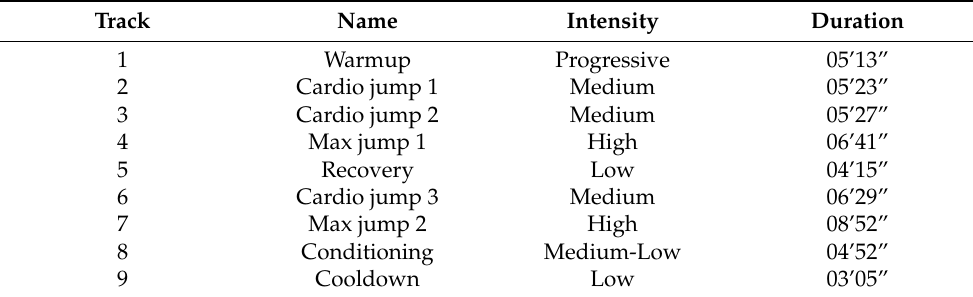
Table 2. Structure of Body Jump ®